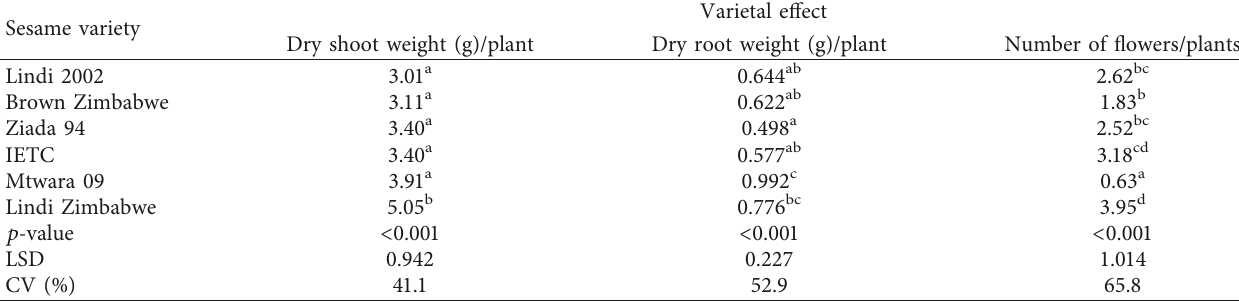
Table 3: Effects of sesame variety on the dry shoot weight, dry root weight, and number of flowers.